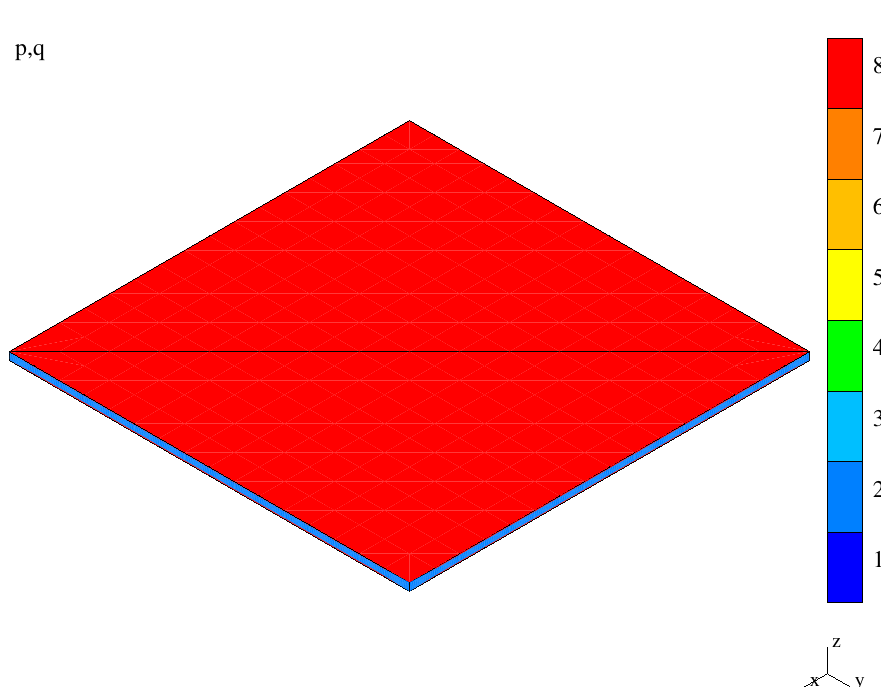
Figure 11. A quarter of a bending-dominated plate—after simple detection, no hp -adaptation.